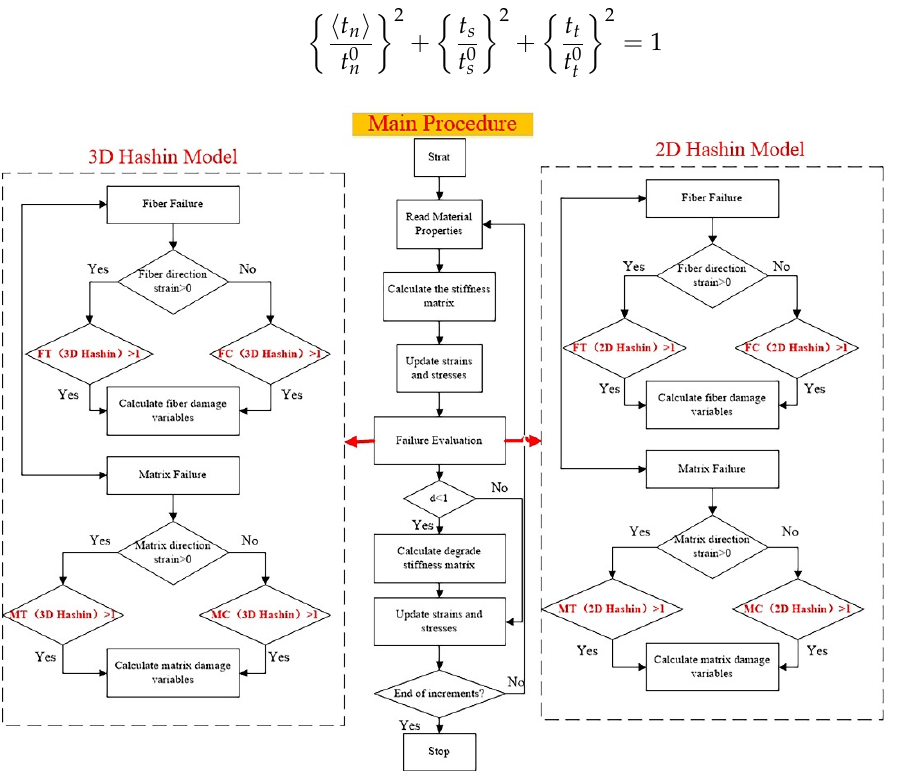
Figure 7. The linear relationship between fibre tensile and compression damage in the 3D Hashin VUMAT subroutine [29].